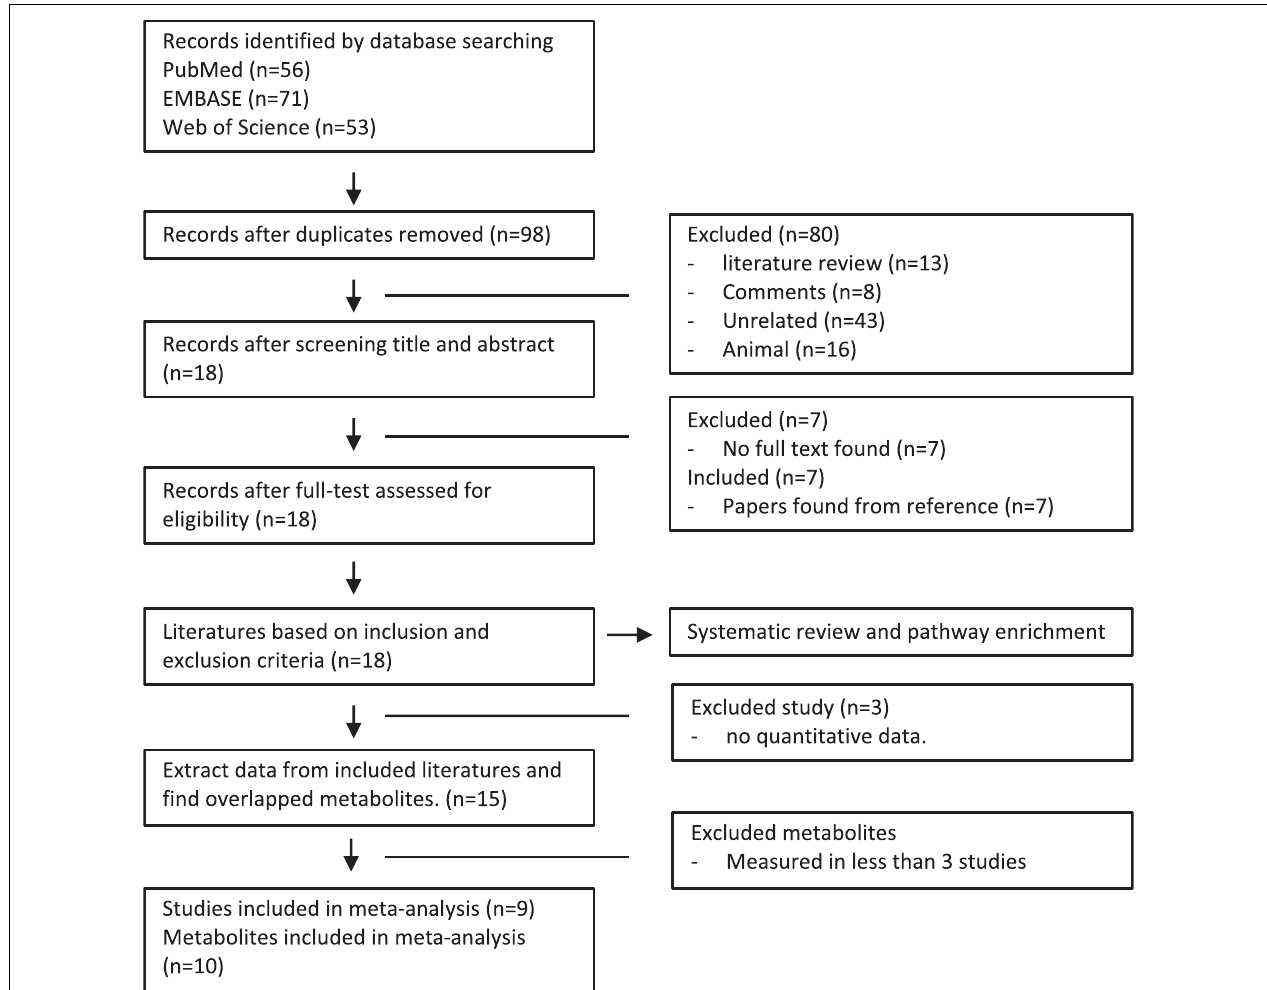
FIGURE 1 | Flow diagram of literature search and study selection in patients with POAG and